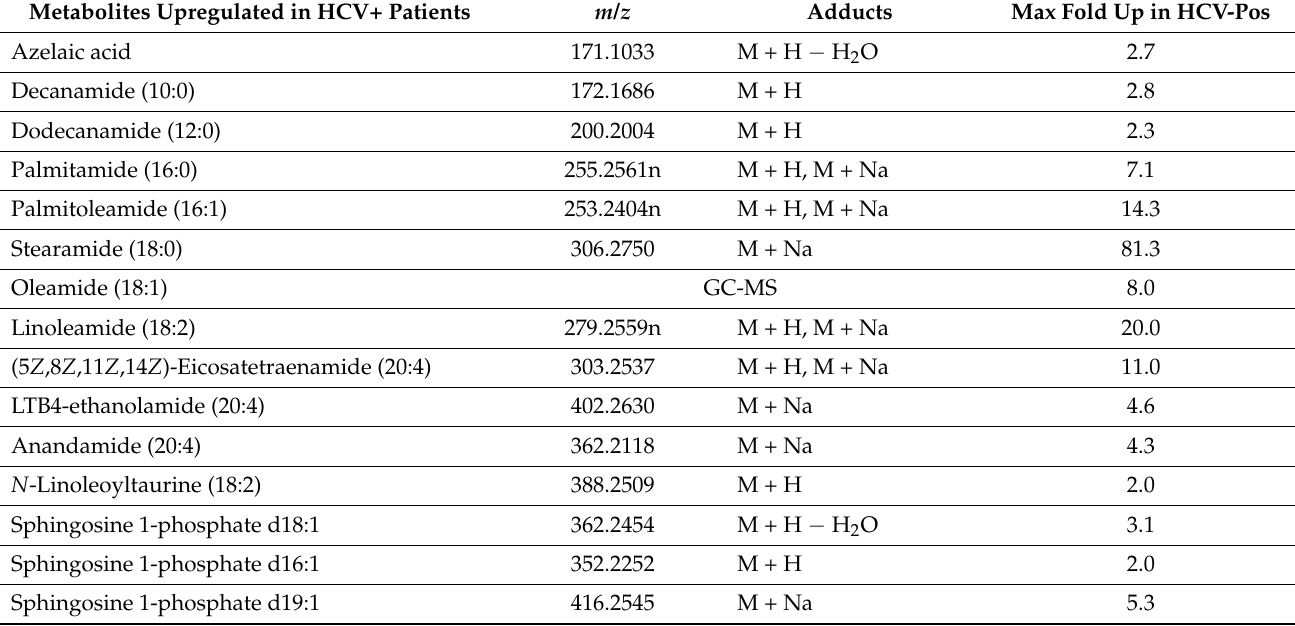
Table 1. Plasma metabolites up- and down-regulated in HCV-positive patients determined by UPLC-ESI-QTOFMS.